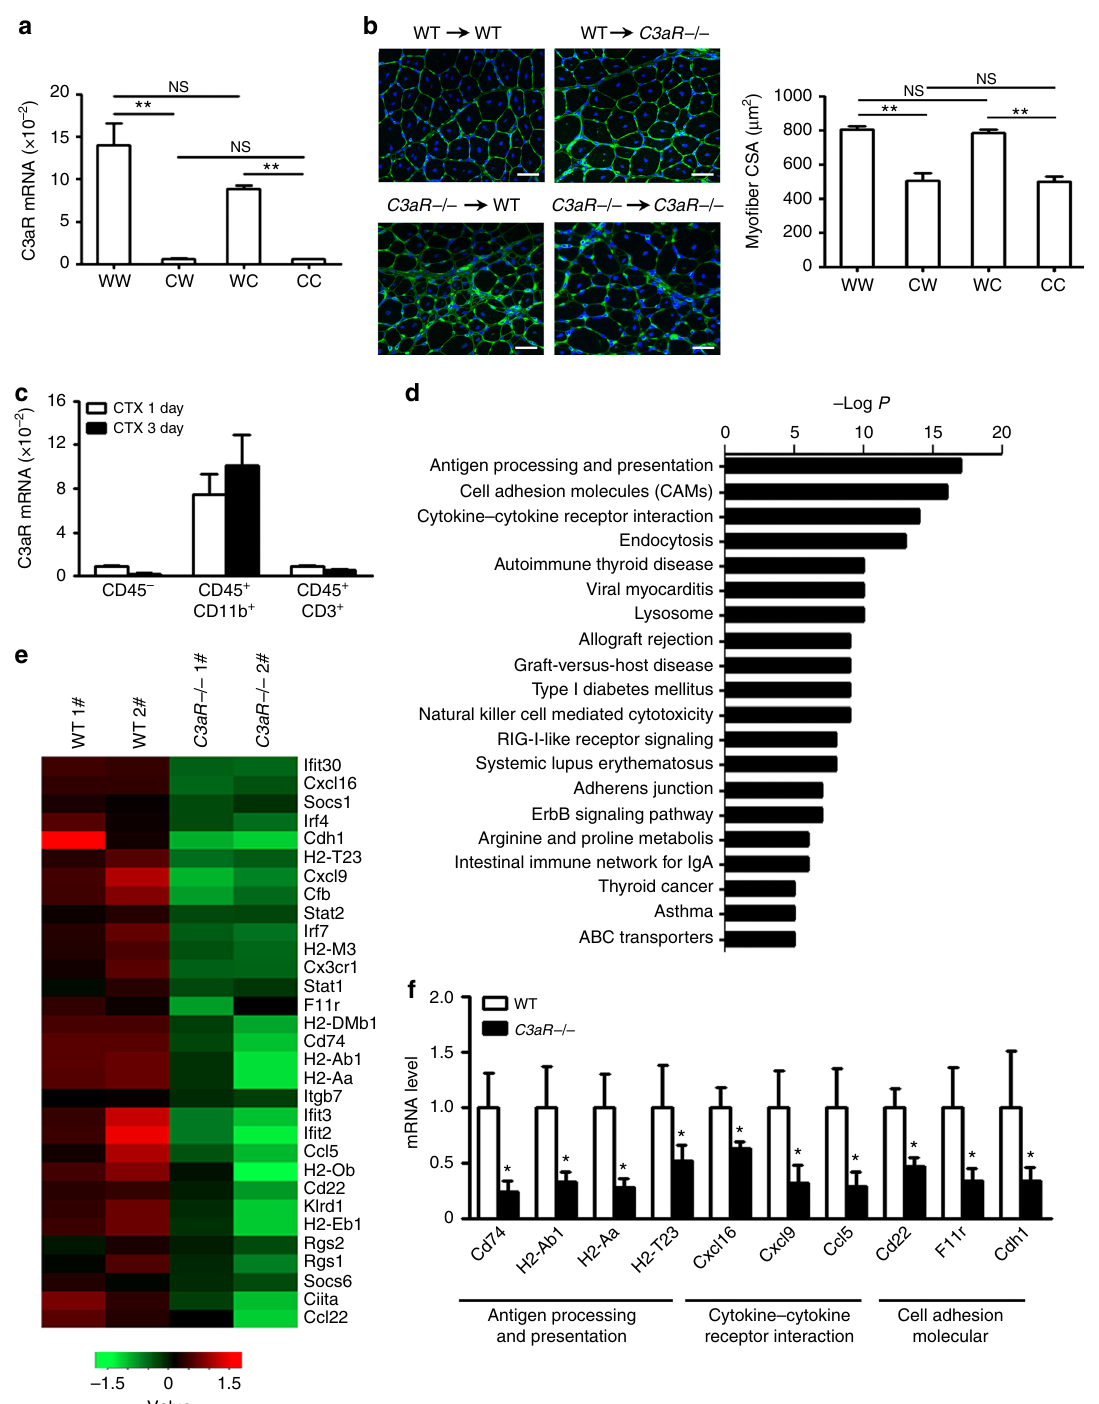
Fig. 6 Macrophage expressed C3aR mediated macrophage activation and muscle regeneration. a C3aR mRNA levels of bone marrow cells from four groups of chimeric mice (WW, WT to WT; CW, C3aR − / − to WT; WC, WT to C3aR − / − ; and CC, C3aR − / − to C3aR − / − ) were accessed by real-time PCR. ( N = 4 in each group). b Four groups of chimeric mice were injured by CTX injection. After 15 days, the regenerating myo fi ber CSA were examined by WGA staining. The right graph indicated the mean CSA of four group ( N = 4 in each group, graphs show representatives of two independent experiments). c Muscle resident cells (CD45 − ), monocytes (CD45 + CD11b + ), and T cells (CD45 + CD3 + ) were isolated from injured muscles (1 day and 3 day after injury) by fl ow sorting. Then, real-time PCR was used to detect C3aR mRNA expression levels of each type of cells ( N = 3 in each group). d CD11b + cells were sorted from WT and C3aR − / − muscle at day 1 after injury, then the transcription expression pro fi ling were accessed by RNA-seq. The KEGG pathway of downregulated genes in C3aR − / − cells was analyzed. e Some different expressed genes in WT and C3aR − / − CD11b + cells associated with the top three pathways were shown as heat map. f Real-time PCR veri fi ed the mRNA levels of ten genes associated with the top three changed pathways in WT and C3aR − / − CD11b + cells ( N = 3 in each group). Data are expressed as the mean ± s.e.m. * P < 0.05, ** P < 0.01, unpaired t -test,